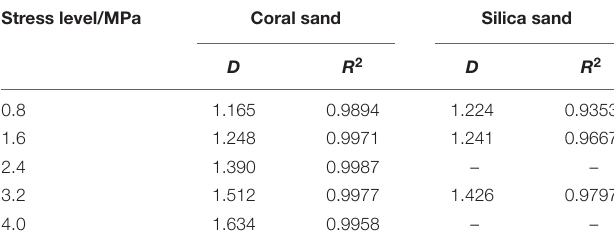
TABLE 4 | Fractal dimension comparison between coral sand and silica sand (2–5